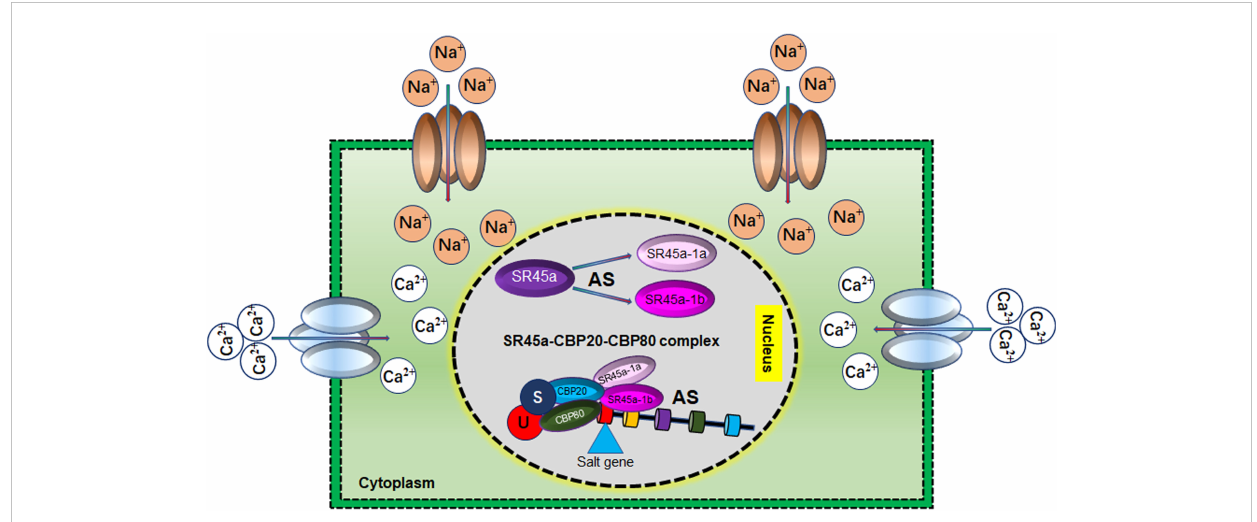
FIGURE 8 Role of alternative splicing (AS) in Salt tolerance Under salt stress conditions, AS of SR45a generates two variants SR45a-1a and SR45a-1b. These AS variants interact with CBP20 and CBP80 to form a regulatory cascade that regulates the alternative splicing of salt stress ‐ responsive genes. SR45a-1a and SR45a-1b regulate the salt tolerance in isoform-dependent